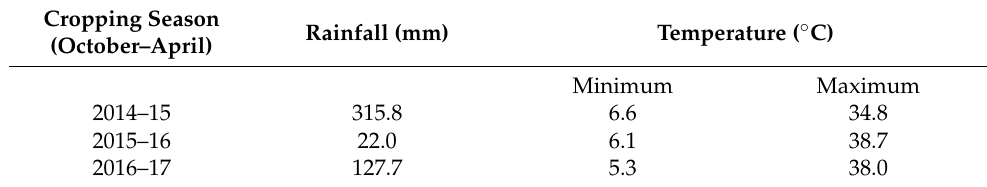
Table 1. Rainfall and temperature data for the chickpea growing seasons for three years. Cropping